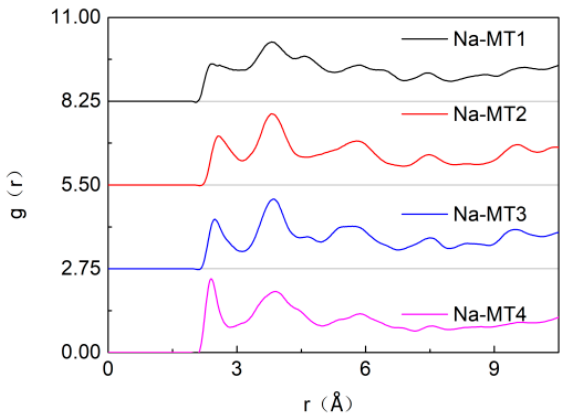
Figure 10. The RDF of O t -Na in Na-MT with different layer charge density.